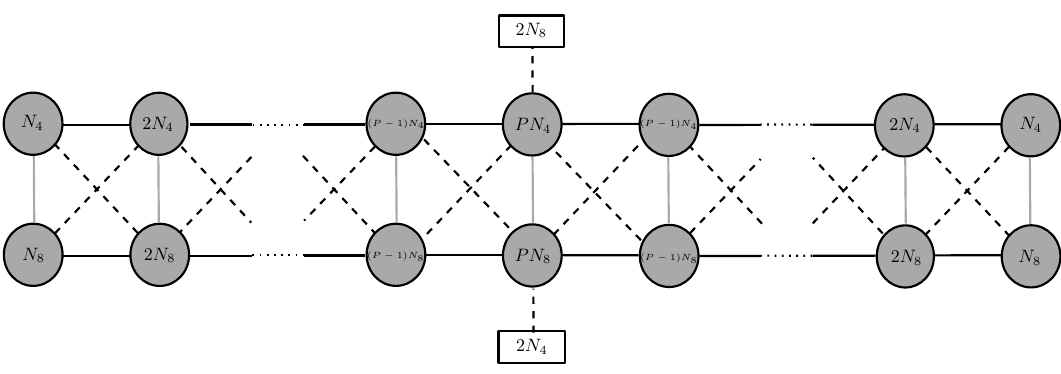
Figure 5 . Symmetric quiver associated to the NATD solution glued to